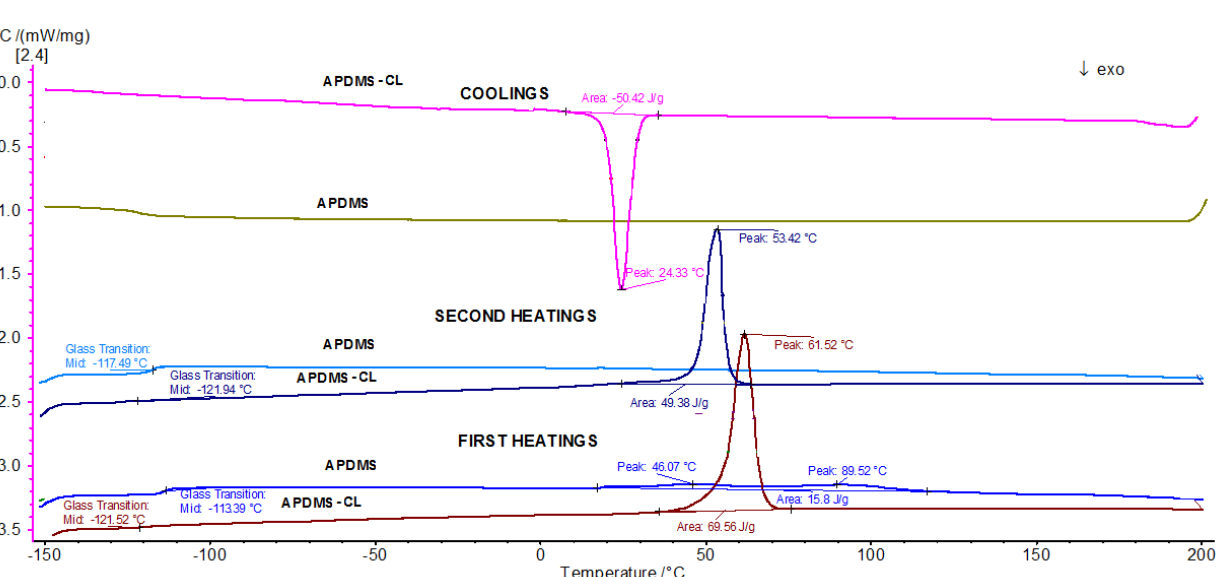
Figure 7 . Tomato plants 7 days after planting . In order to determine the germination index, it was necessary to measure the length of the plant root. Table 1 presents the average length of the plant roots 35 days after plant- ing and the germination index. Table 1. The average length of plant roots and germination index . Analyzes